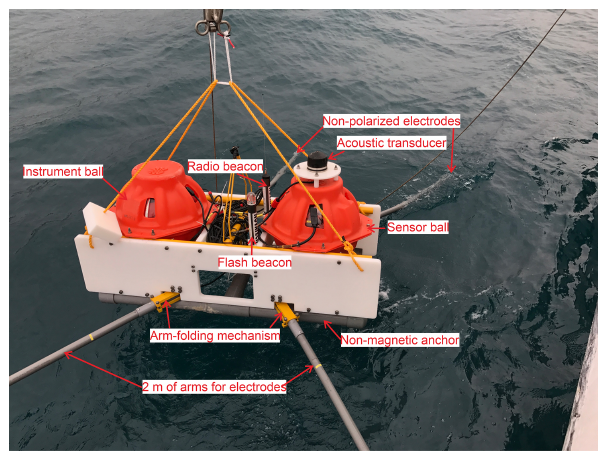
Figure 3. A photograph of the OBEM01 and its specific